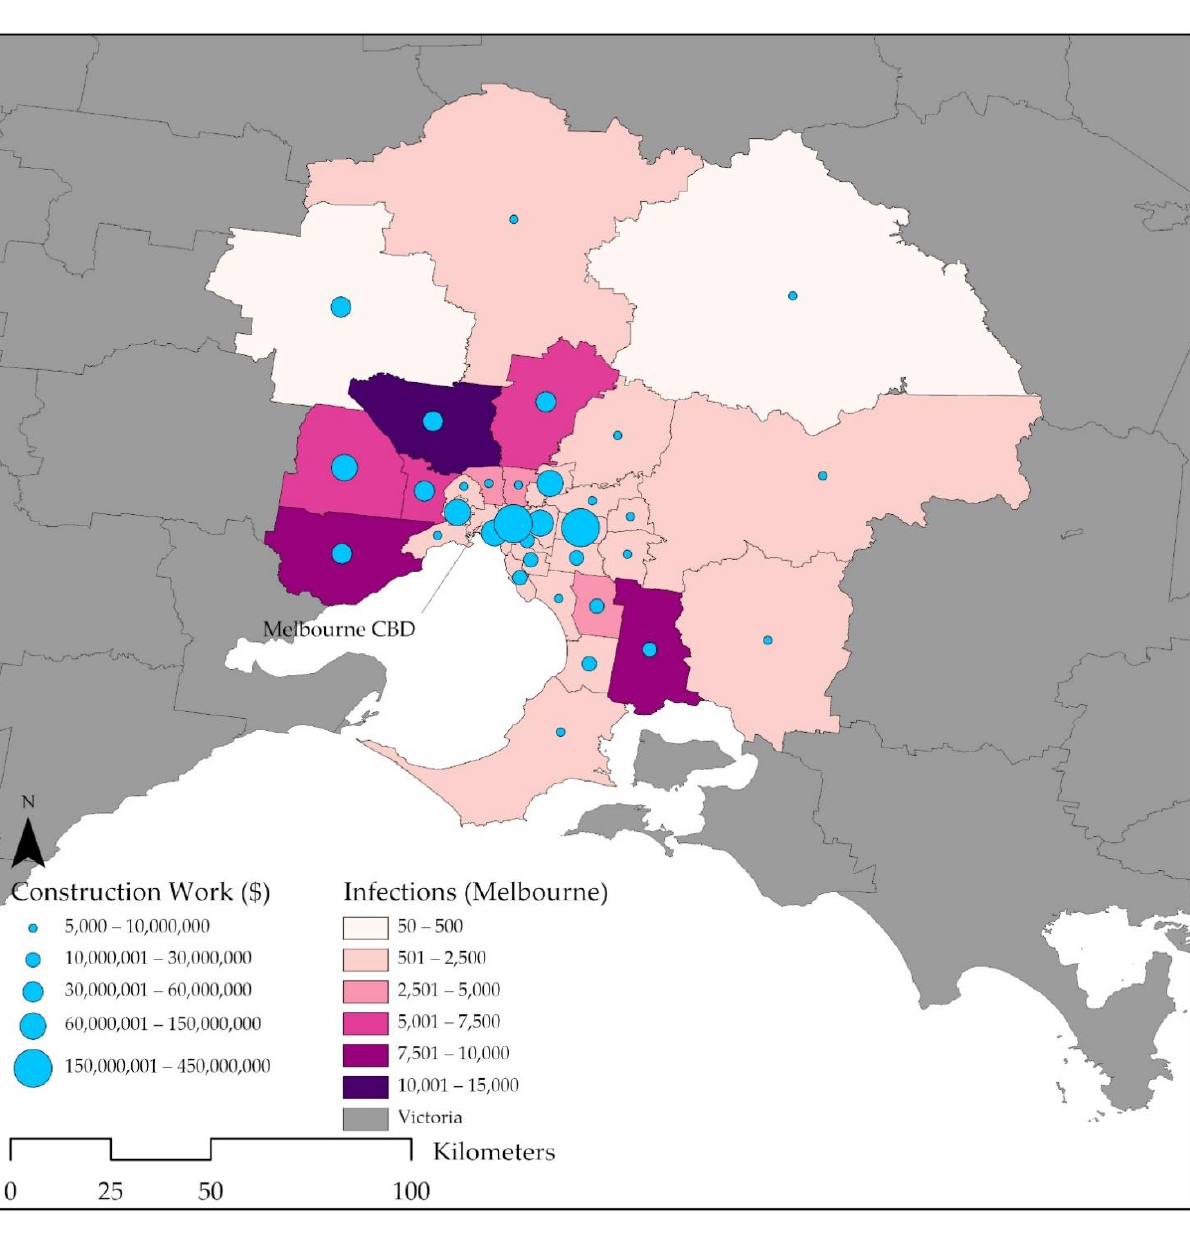
Figure 14. Choropleth maps showing COVID-19 cases overlayed by graded symbology showing the value of construction work across ( a ) Sydney and ( b ) Melbourne.